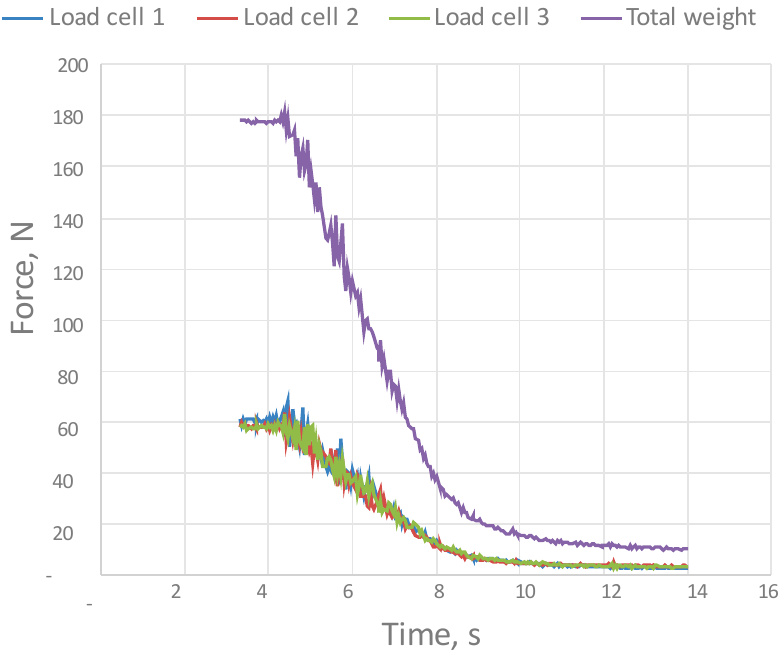
Figure 2. Loads on the three load cells supporting the container and weight of the material in the container vs. discharge time.